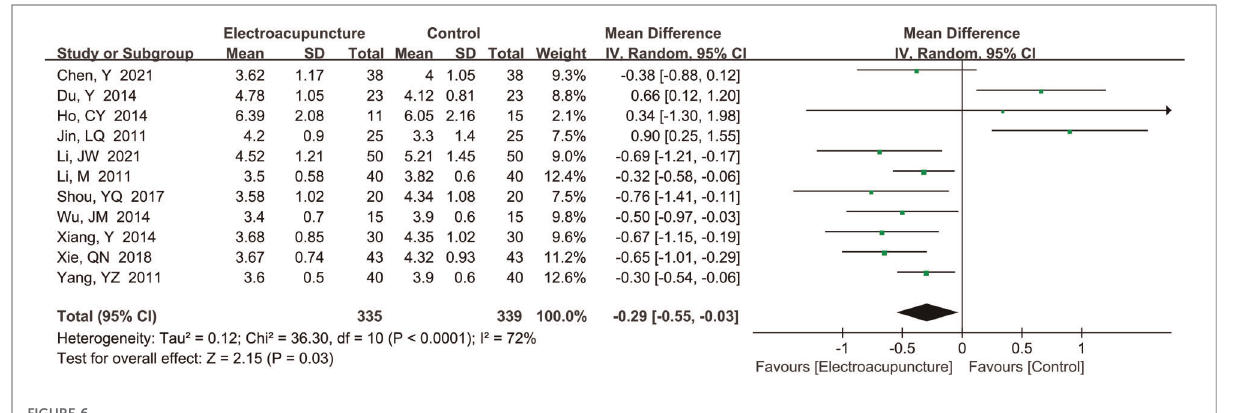
FIGURE 6 A forest plot showing the DML.